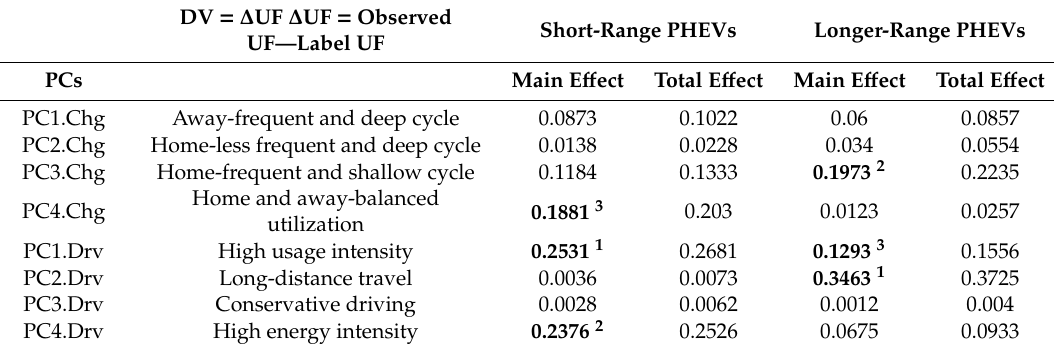
Table 11. Relative contribution of IVs to total predictable